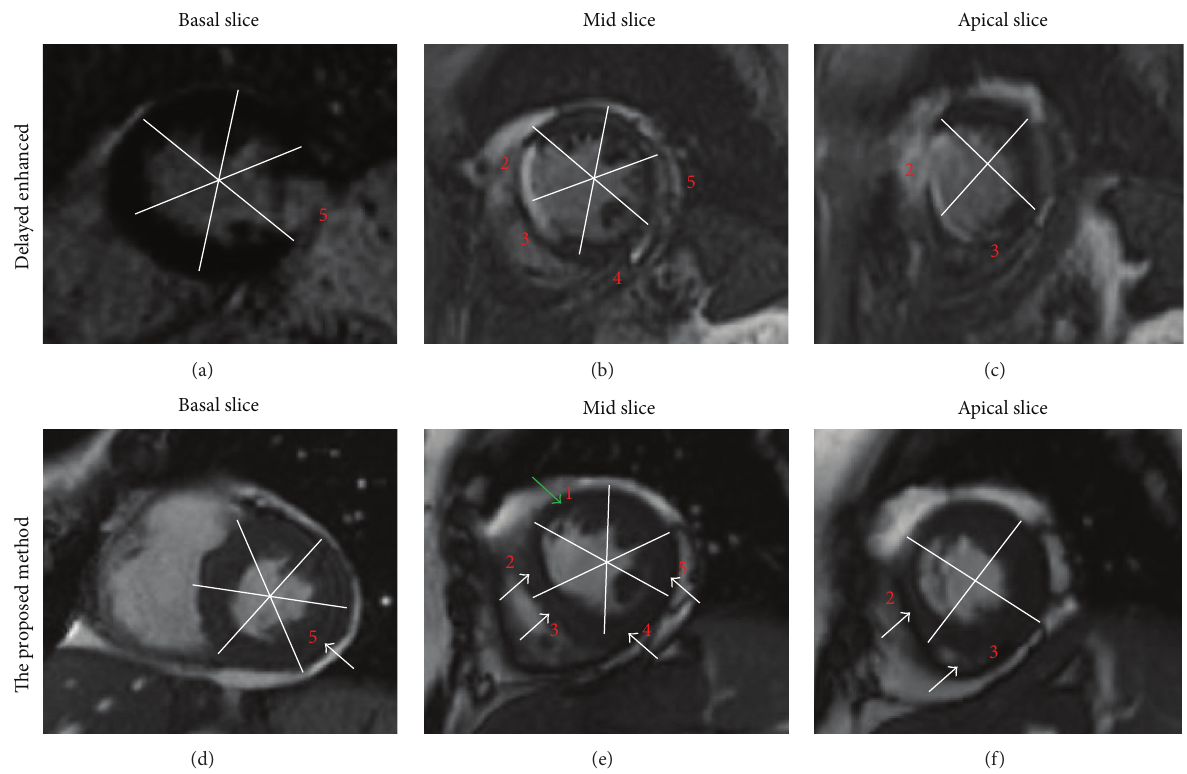
Figure 3: Comparison between (a–c) infarcted regions using delayed enhancement (DE) MRI and (d–f) regions with motion abnormality detected using the proposed